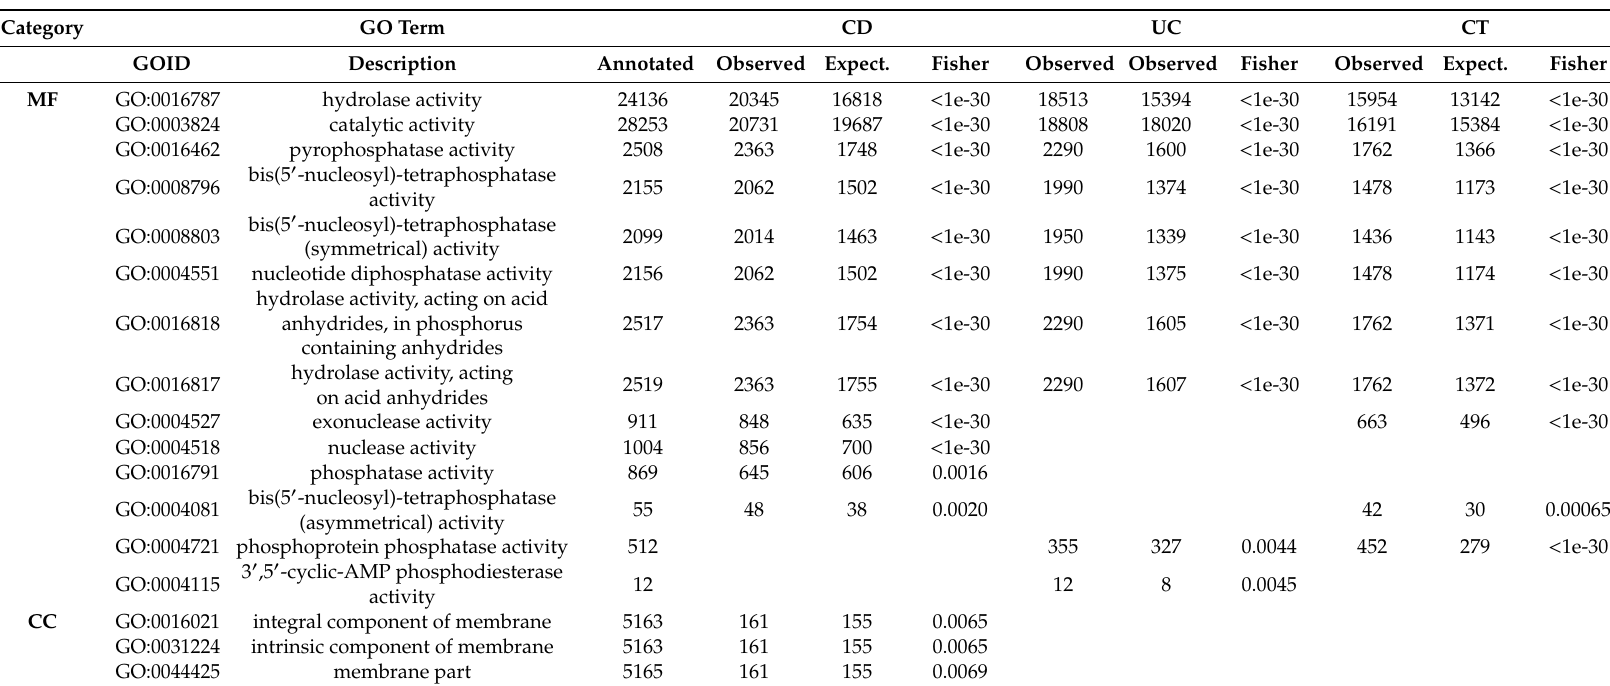
Table 4. Gene ontology enrichment for bacterial candidate proteins, only terms showing a significant ( p < 0.01) enrichment have been reported. Category: MF (molecular function), CC (cellular component). Terms: number of proteins annotated with a given GO term. Observed: number of proteins observed with a given GO term. Expected: number of proteins expected with a given GO term. Fisher: p -value according to the exact-Fisher